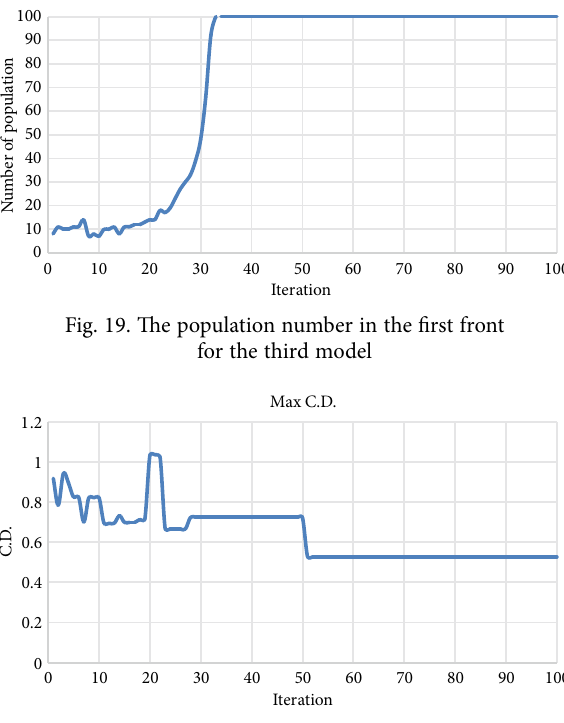
Fig. 20. Maximum values of the congestion